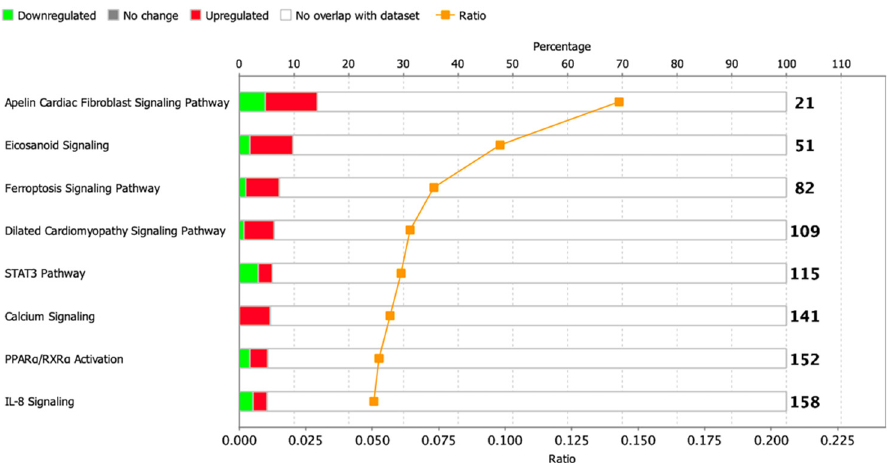
Figure 6. Dysregulated signaling pathways in postinfarction CMC samples identified by IPA analysis. The histogram represents the dysregulated canonical signaling pathways in a stacked bar chart by Fisher’s Exact Test p-value ( p -value > 0.05, z-score > 1). The ratio plot shows the number of significant genes expressed in the data versus the total number of genes in that particular signaling pathway.